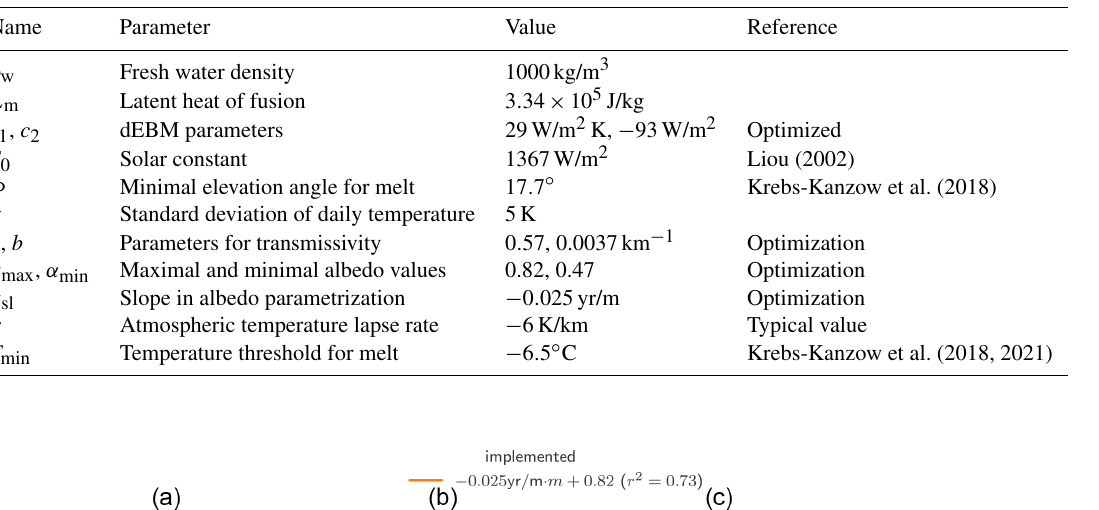
Table A2. Parameters used in dEBM-simple.